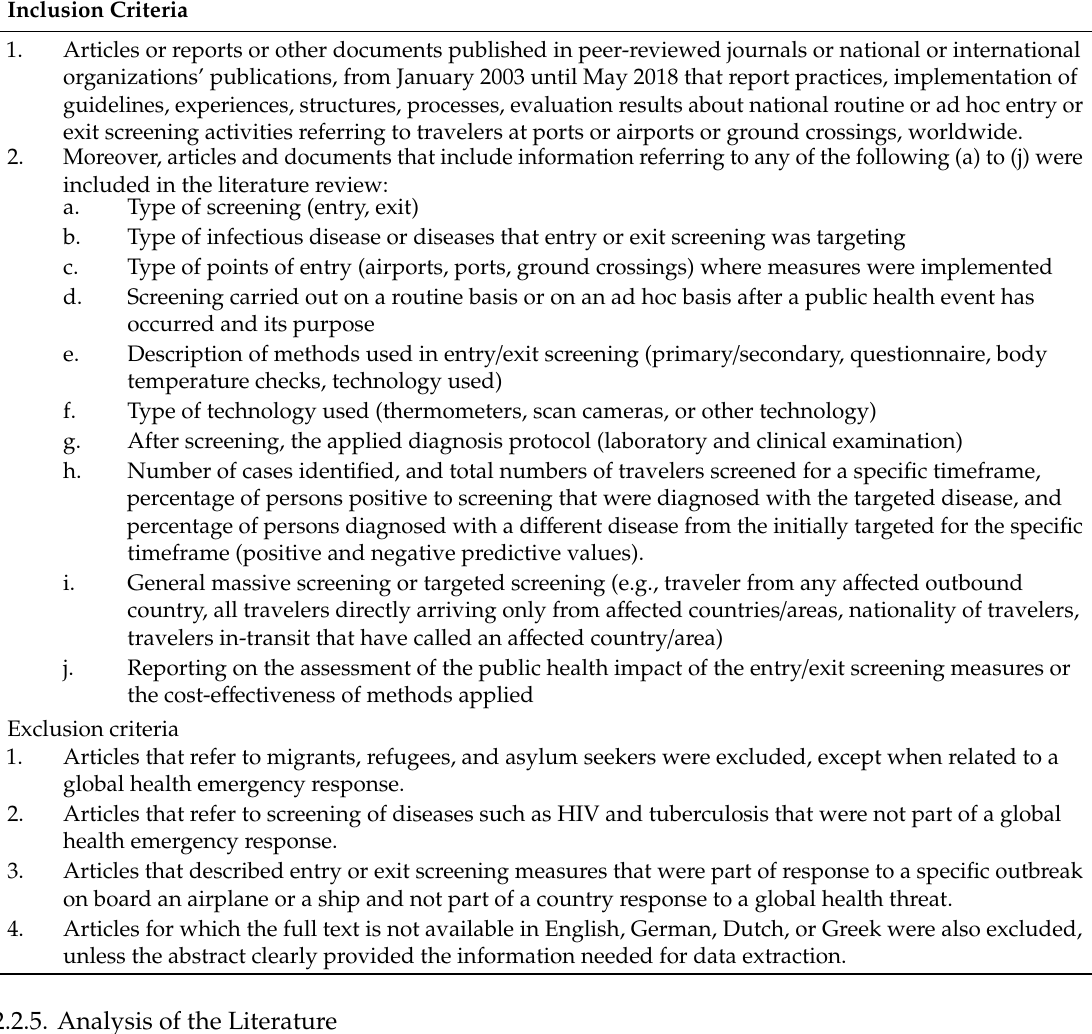
Table 2. Inclusion and exclusion